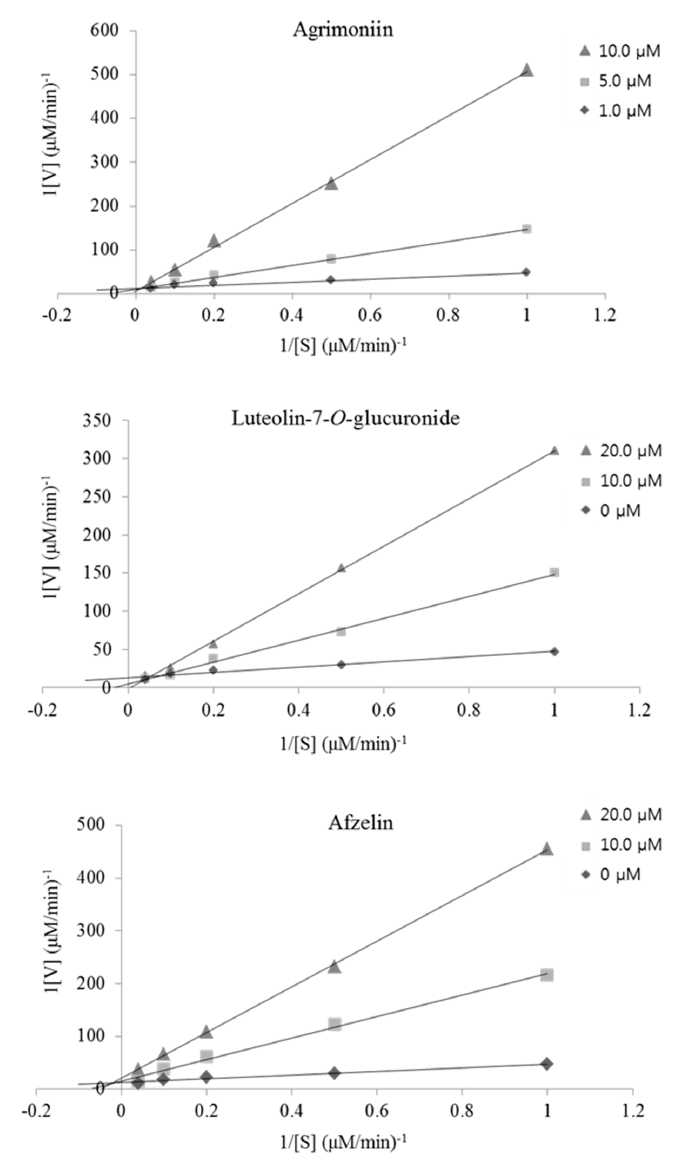
Figure 4. Lineweaver–Burk plots showing the reciprocal of the velocity (1/V) of recombinant rat lens aldose reductase versus the reciprocal of the substrate concentration (1/S) with DL -glyceraldehyde as the substrate at concentrations of 1.0 to 25.0 mM.